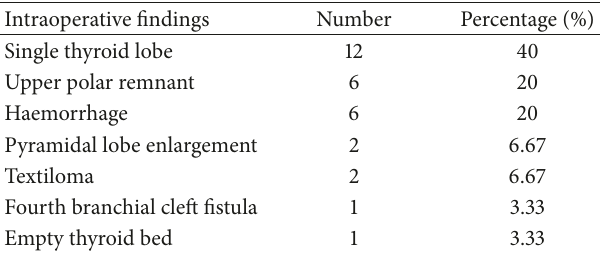
Table 3: Distribution of patients according to intraoperative find-